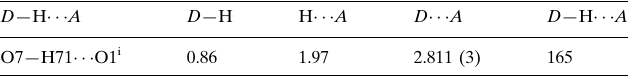
Hydrogen-bond geometry (A˚ , (cid:2)